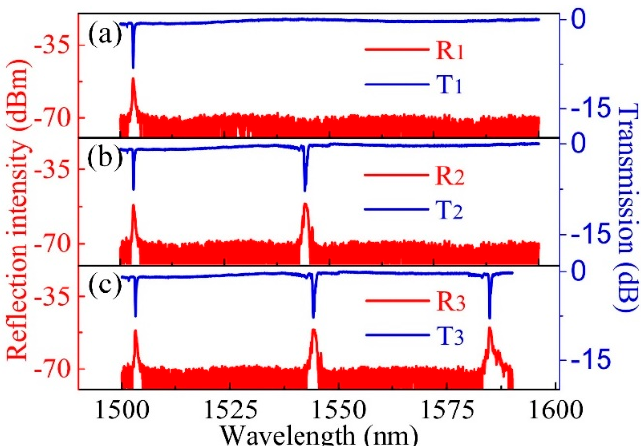
Figure 6. ( a – c ) Spectra evolution (red line: reflection; blue line: transmission) of an FBG array consists of three high-reflection FBGs. The resonant dips of the three FBGs are ~ − 7.5, − 7.7 and − 7.9 dB, respectively.